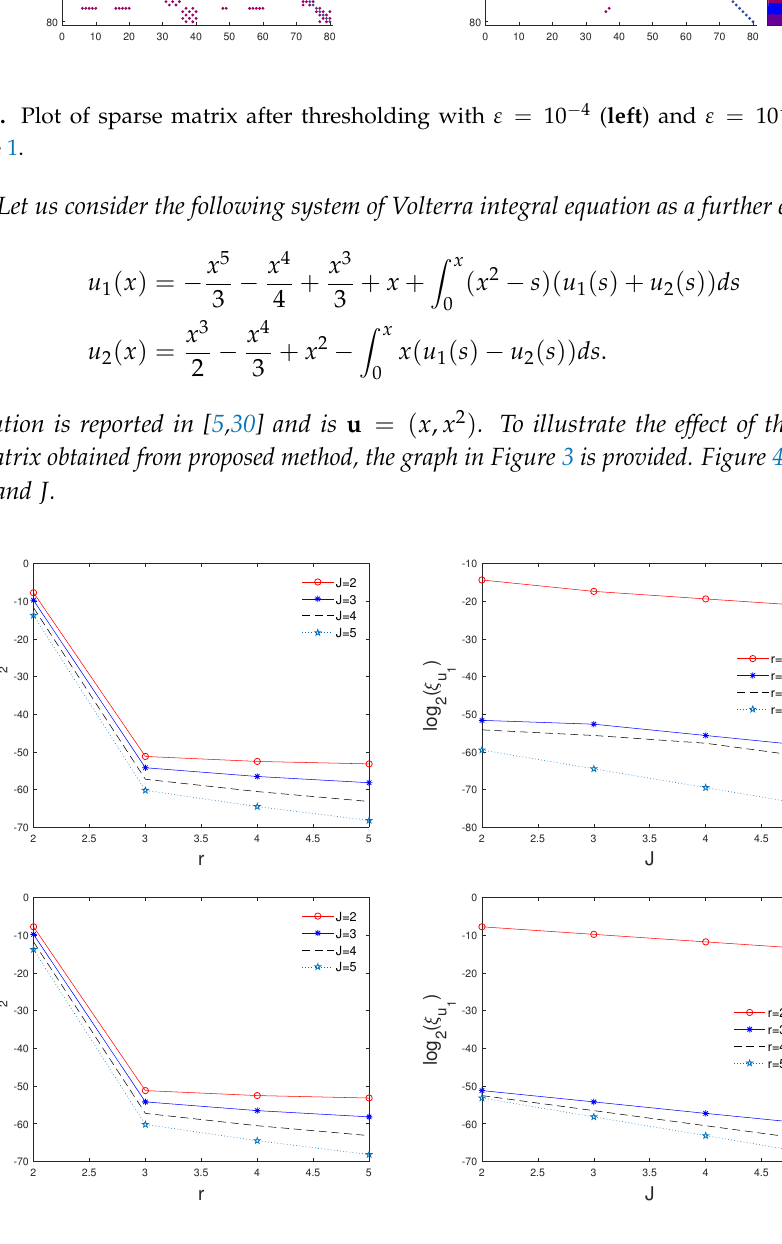
Figure 3. Effects of the refinement level J ( left ) and the multiplicity parameter r ( right ) on L 2 error when r = 4 and J = 3 for Example